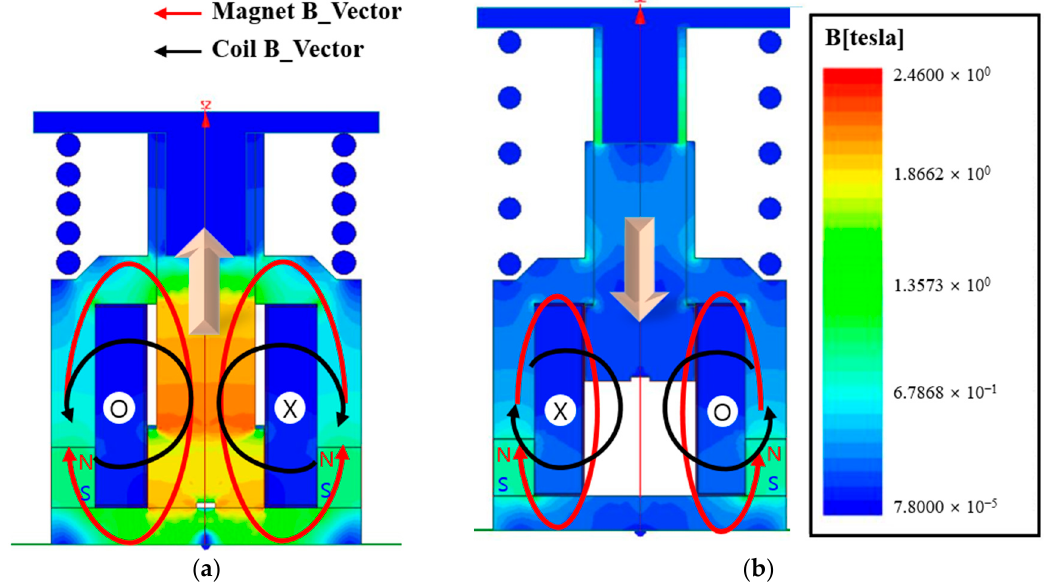
Figure 6. Magnetic flux vector of one-coil actuator during ( a ) opening and ( b ) closing operations. Figure 7 is a flow chart for one-coil long-stroke PMA development. The validity of